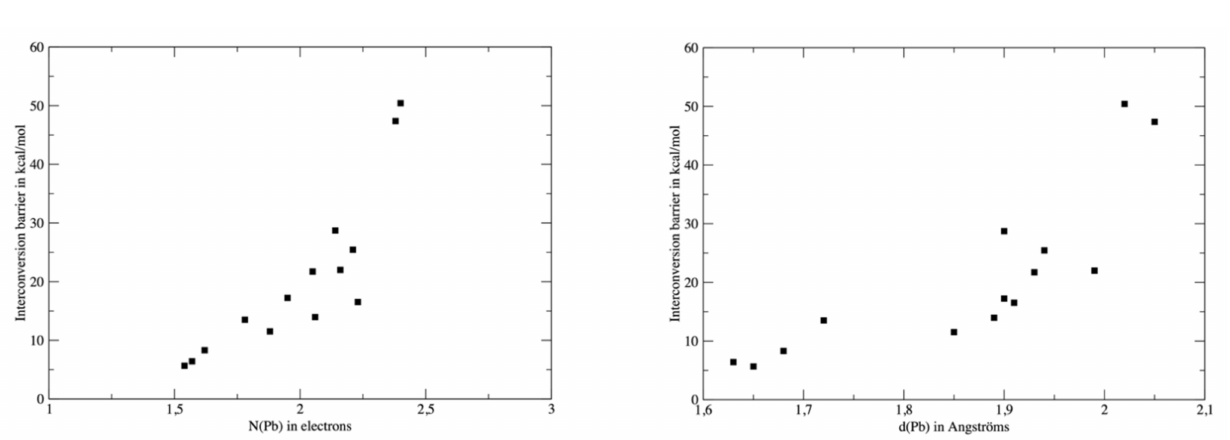
Figure 8. Values of the interconversion barrier against N(Pb), ( left ) or d(Pb) ( right ). Values were computed at the DFT level of theory with the ω B97XD